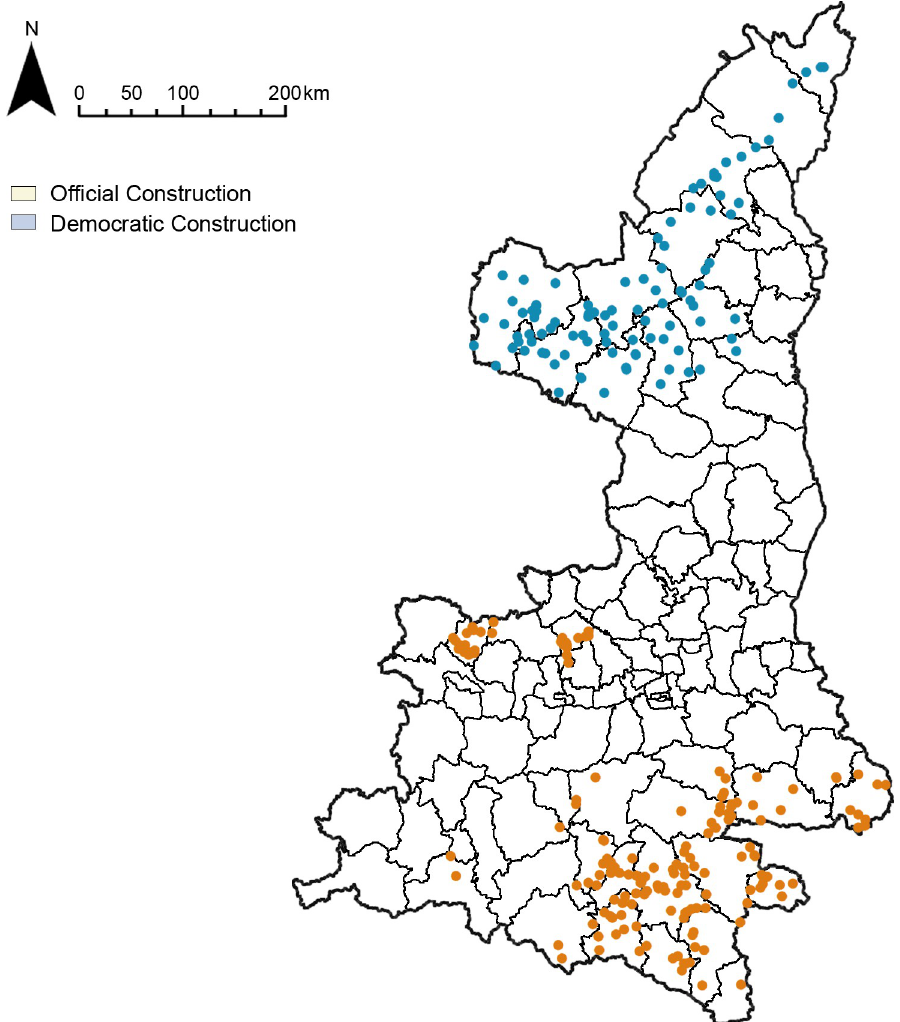
Fig 11. Distribution map of different construction